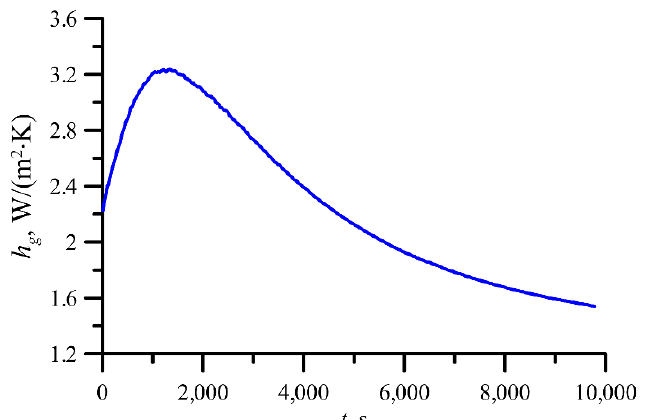
Figure 12. Changes in the heat transfer coefficient h g on the surface of the heat accumulator packing elements as a function of time.